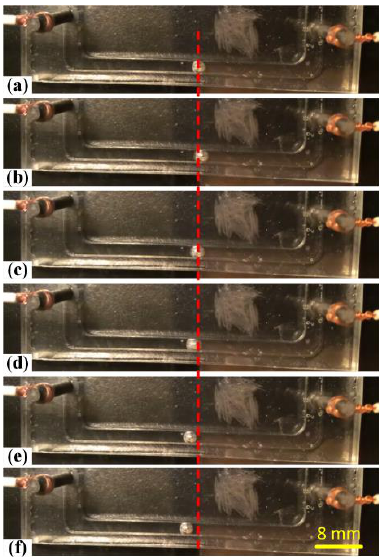
Figure 8. ( a – f ) Forward locomotion while oscillating of the liquid metal slug between two driving electrodes upon the application of a sinusoidal wave signal of 50 Vpp at 4 V DC offset at the frequency of 15 Hz.